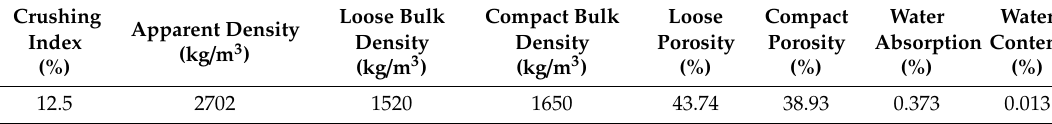
Table 3. The physical properties of coarse aggregate.